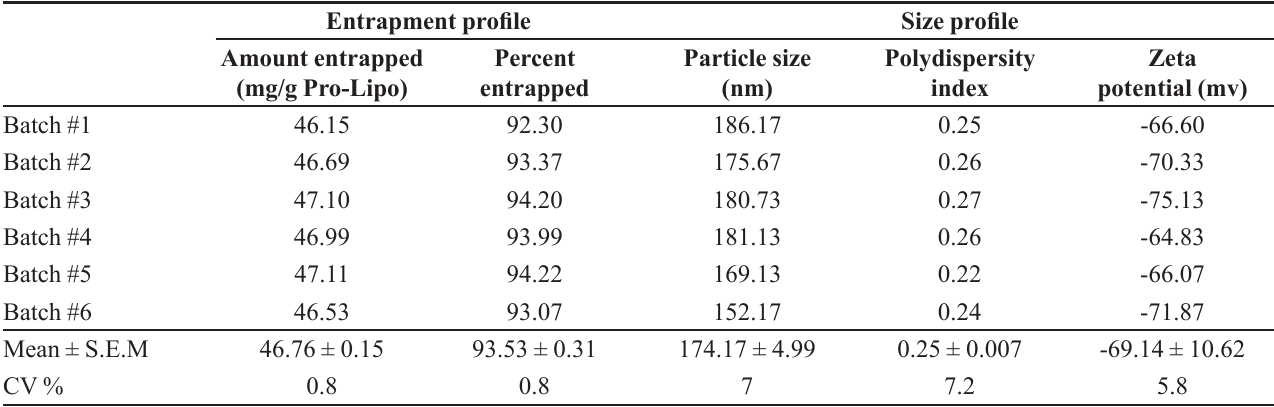
TABLE III - Reproducibility of MFA-DDC based liposomes Entrapment